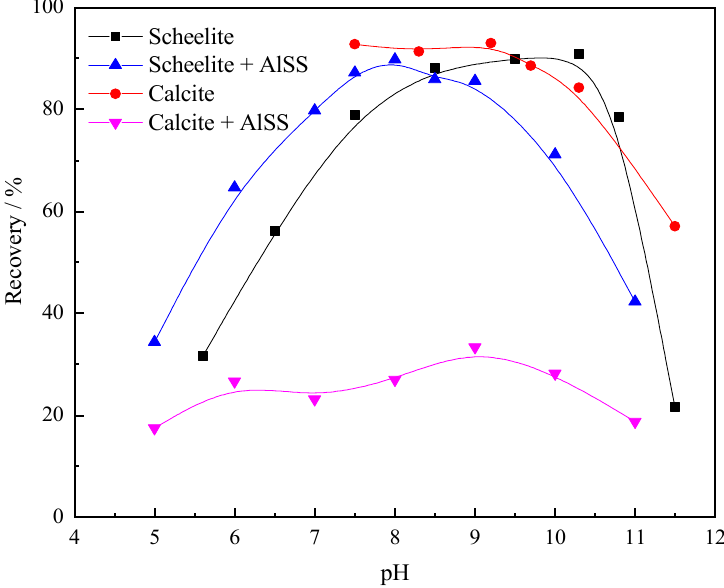
Figure 3. Effect of the Al-Na 2 SiO 3 polymer on scheelite and calcite flotation with the varying pH ( C Alss = 100 mg/L, C lead ion = 3 × 10 − 4 mol/L, C BHA = 1.5 × 10 − 4 mol/L, C terpineol = 12.5 μ L/L).